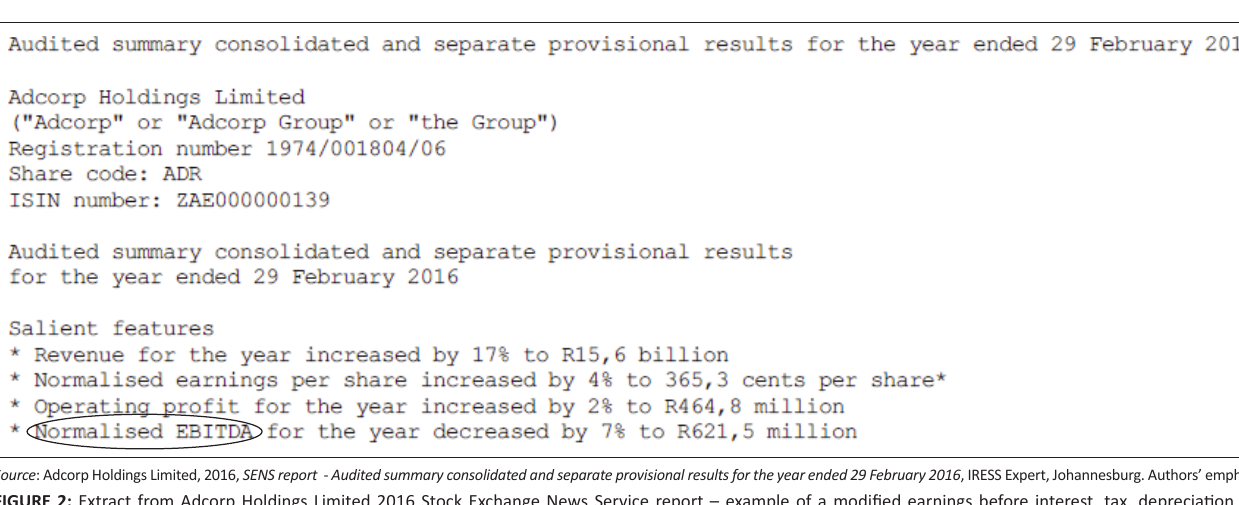
FIGURE 2: Extract from Adcorp Holdings Limited 2016 Stock Exchange News Service report – example of a modified earnings before interest, tax, depreciation and amortisation